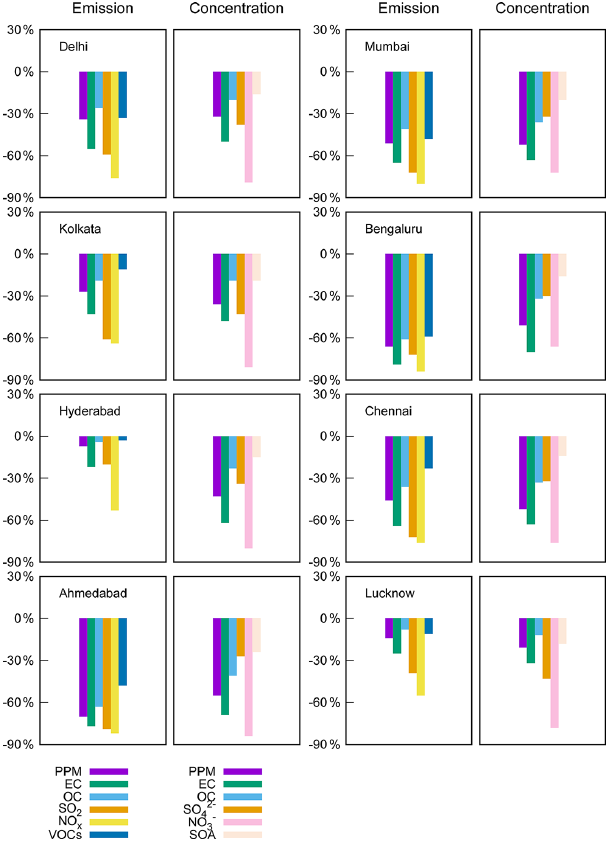
Figure 6. Predicted relative changes in concentrations of primary and secondary components, and emissions of their precursors in eight cities of India in Case 2 to Case 1.